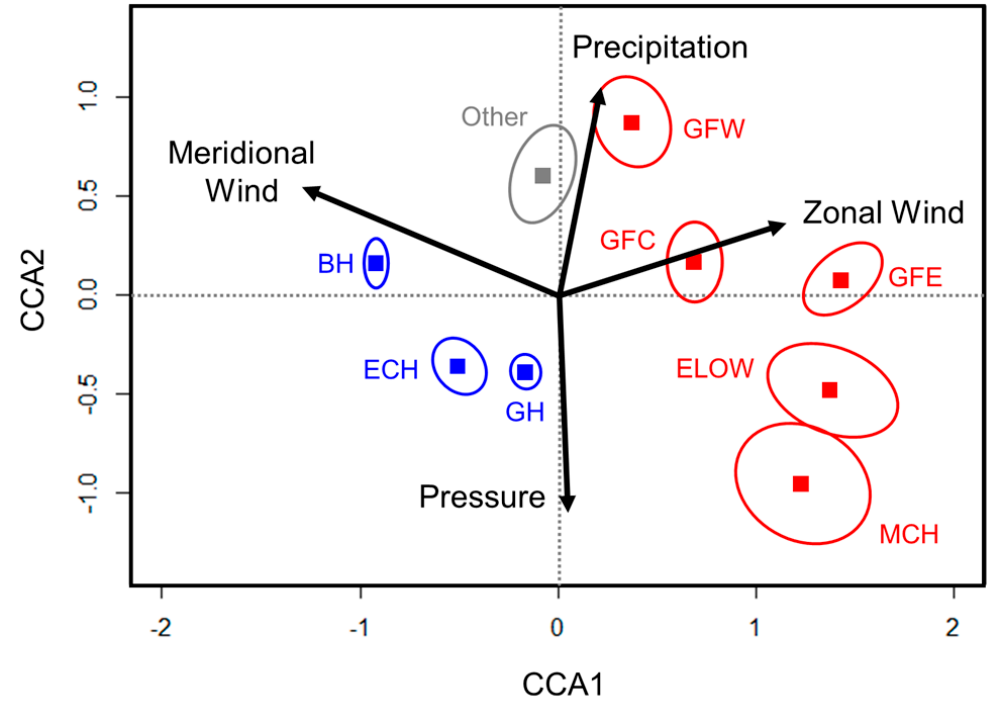
Figure 3. Canonical correspondence analysis plot showing the mean canonical variate values of the nine daily synoptic weather types and the canonical vectors of four continuous weather variables measured throughout the night over the Gulf of Mexico including zonal (blowing east or west) and meridional (blowing north or south) wind speeds (m s − 1 ) at 925 mb, surface air pressure (kPa), and accumulated total precipitation (kg m − 2 ) from North American Regional Reanalysis points over the Gulf of Mexico relative to the first two canonical axes (CCA1 & CCA2). The zonal wind component estimates wind speed in the east–west direction (positive if blowing towards the east and negative if blowing towards the west), and the meridional wind component estimates wind speed in the north–south direction (positive if blowing towards the north and negative if blowing towards the south). All measurements were taken at 6:00 UTC the night prior to migrants departing stopover sites. Ellipses denote the 95% confidence intervals of means for the synoptic weather types, which include five unfavorable for northward migration (e.g., winds blowing south and / or moderate to high amounts of precipitation) in red: Western Gulf Front (GFW), Central Gulf Front (GFC), Eastern Gulf Front (GFE), East Coast Low (ELOW), and Midwest Continental High (MCH); and three favorable for northwards migration (e.g., winds blowing north and little to no precipitation) in blue: Eastern Continental High (ECH), Bermuda High (BH), and Gulf High (GH). The last synoptic weather type of “Other” consisted of a subset of instances that did not fit into one of the eight prior